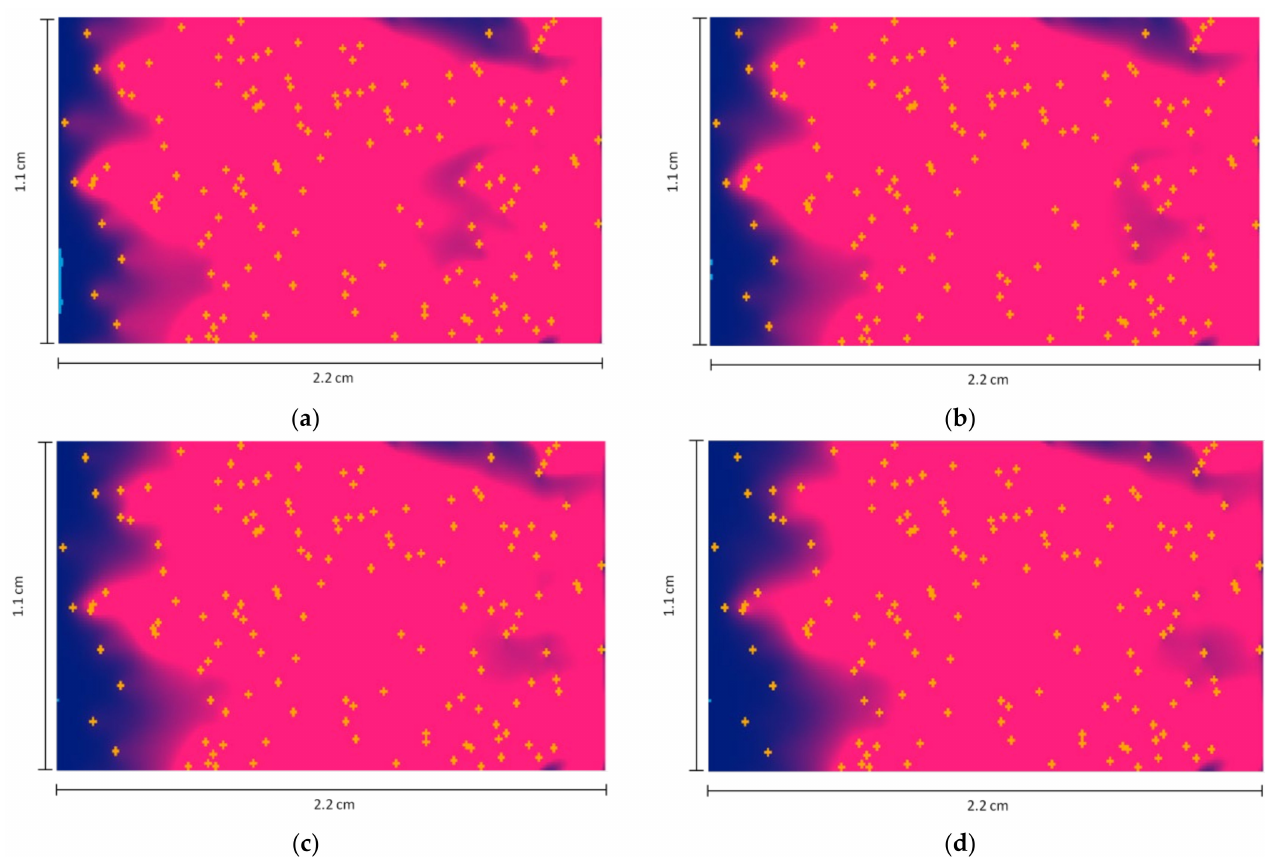
Figure 15. Visualization of the melatonin concentration distribution in the model nasal cavity during the deposition of chitosan-based aerogel particles at different time points: ( a ) 0.75 min; ( b ) 1.5 min; ( c ) 2.25 min; ( d ) 3 min. Color gradient from purple to blue shows the number of API particles in cell from high to low, respectively.